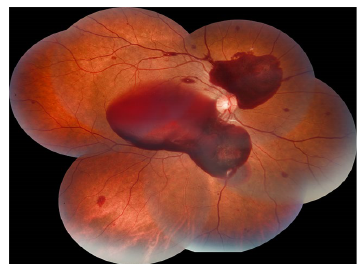
Figure 6. Wide-field Fundus Image